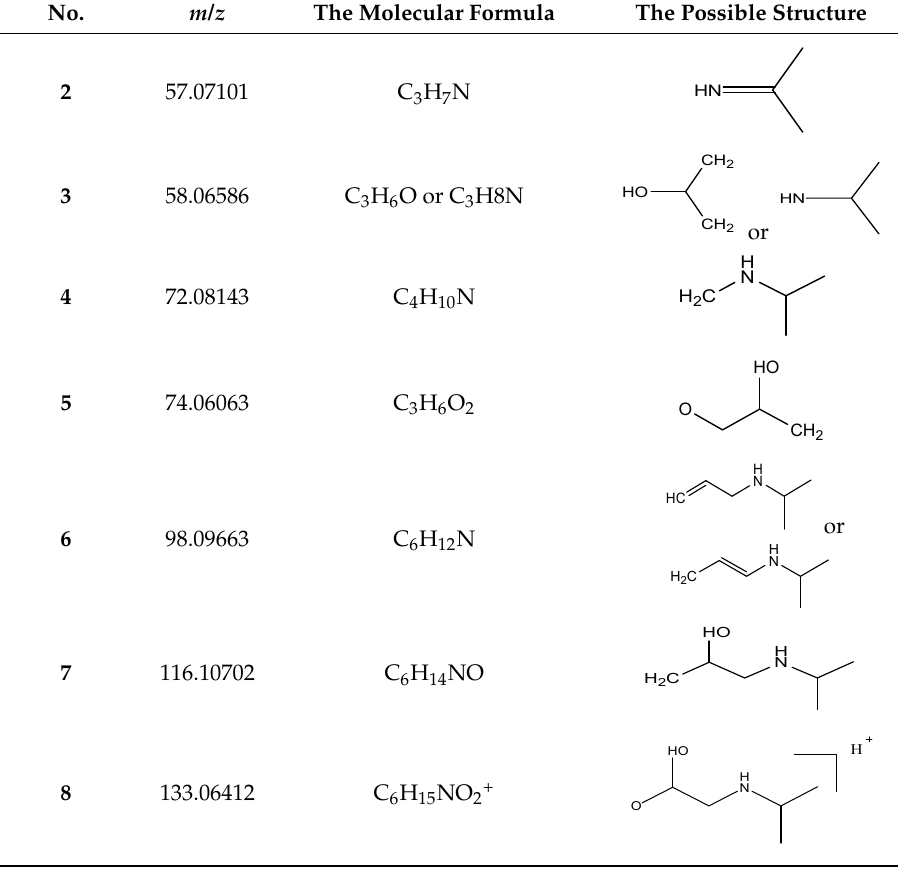
Table 2. The possible structure of corresponding characteristic fragments.